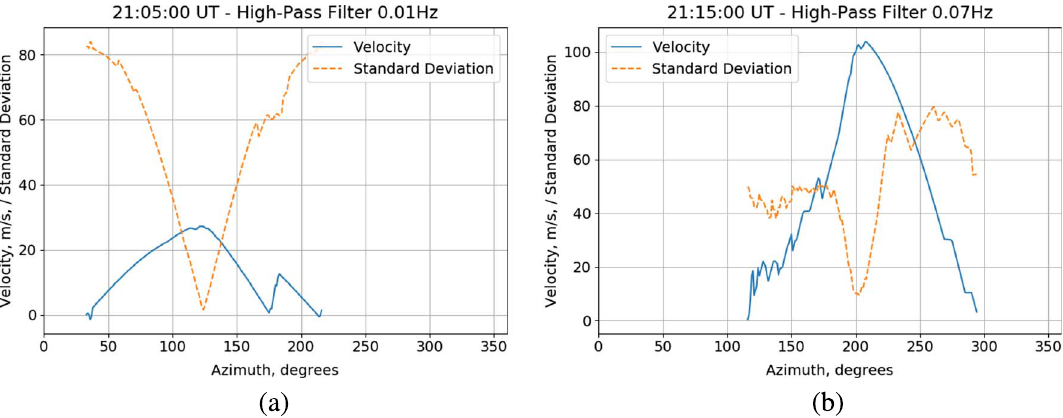
Fig. 7. Plots for single 3-min time slices of the median velocity and standard deviation of velocities about the median versus azimuth direction, calculated from the range of velocities found from all cross-correlation functions with the baselines within each station pair re-calculated for each assumed azimuth direction, in the usual form, counting clockwise from north. (a) Time slice commencing 21:05:00 UT using cross- correlations calculated after applying a high-pass fi lter at 0.01 Hz. (b) Time slice commencing 21:15:00 UT using cross-correlations calculated after applying a high-pass fi lter at 0.07 Hz. Note that the same y -axis is used for both velocity and standard